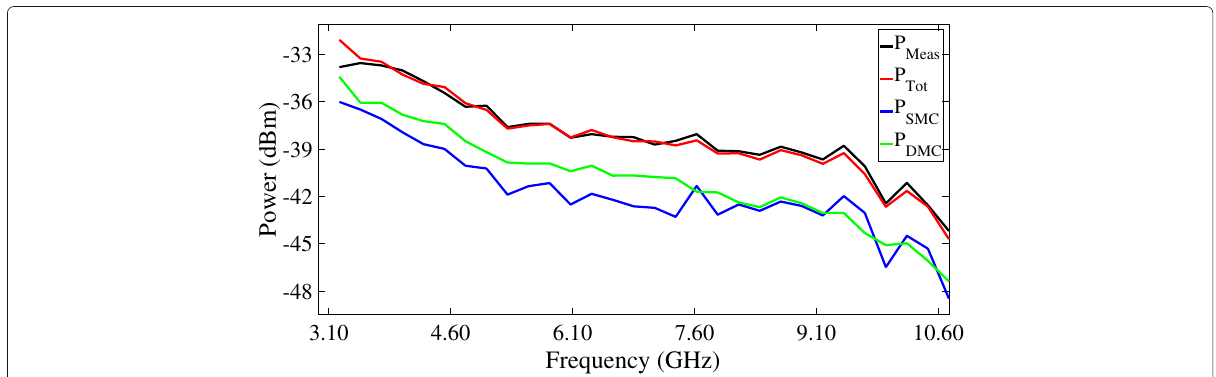
Fig. 18 Mean values of the measured powers in the radio channel as a function of UWB frequencies: NLoS scenario